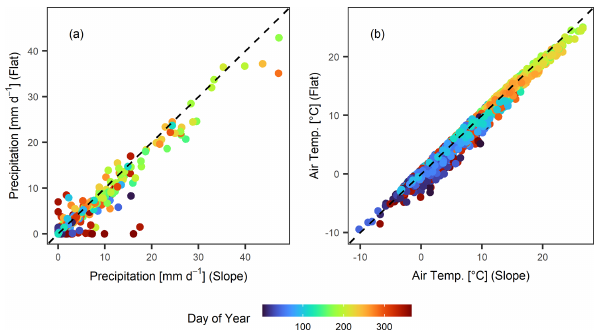
Figure 3. Sloped vs. flat daily precipitation sums (a) and daily mean air temperature (b) . The point colour indicates the day of the year. In panel (a) , only days with liquid precipitation are shown (not snow- fall), because the rain gauge was heated at the sloped site